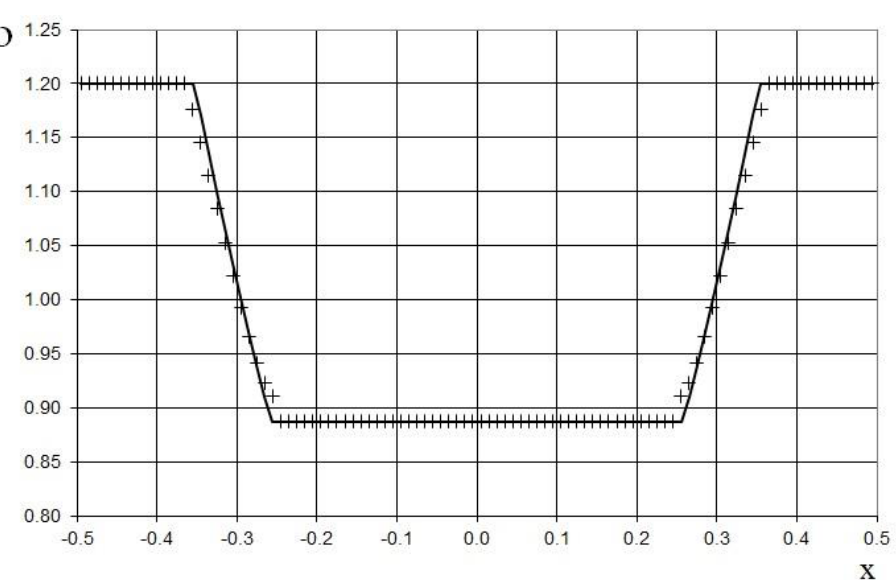
Figure 8. Density plot for the double expansion wave problem (47) for the adiabatic gas dynamics equations: the exact solution (line), and the present method (cross).